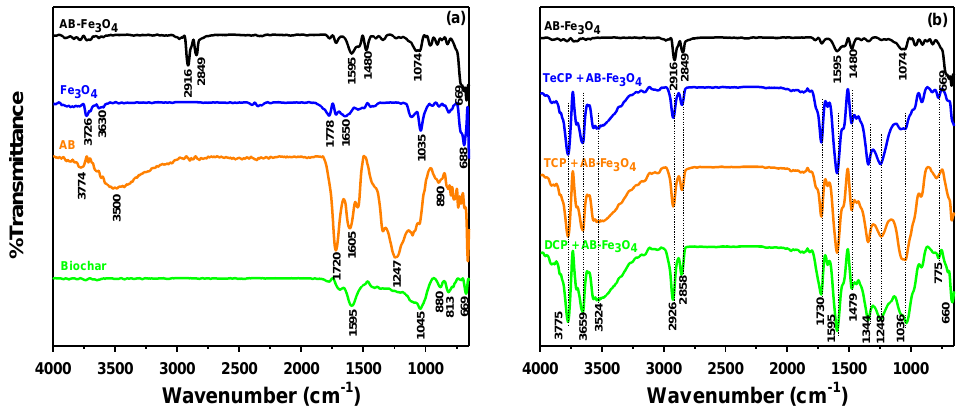
Figure 2. FTIR spectra of ( a ) biochar, AB, Fe 3 O 4 , and AB-Fe 3 O 4 and ( b ) AB-Fe 3 O 4 before and after TeCP, TCP, and DCP adsorption.